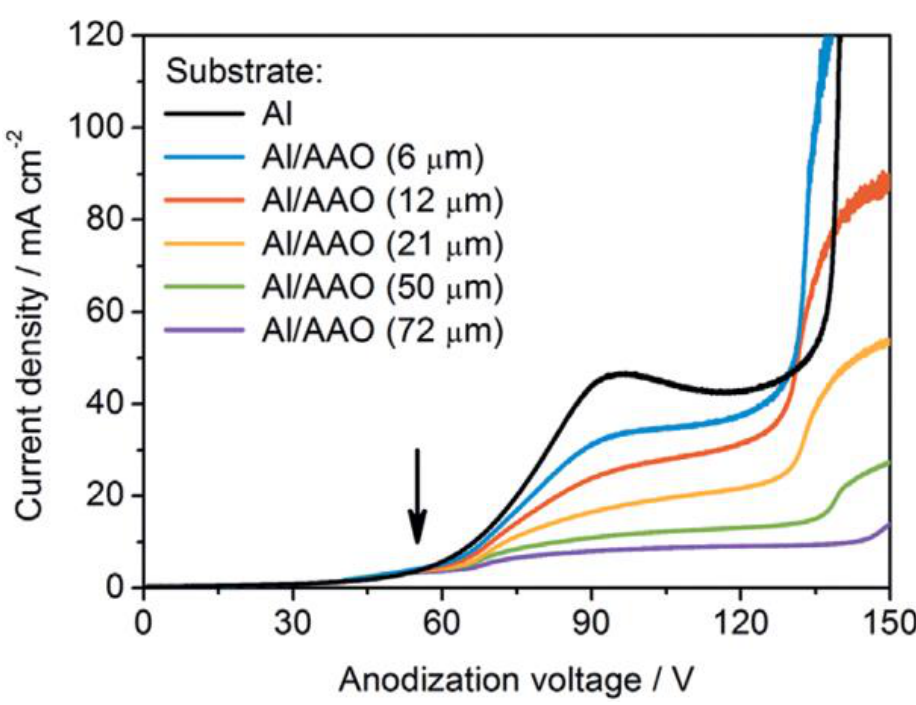
Figure 29. j – ∆ U curves obtained using two different types of Al anodes: a bare metallic foil near which the electroconvective vortical structures can freely change their sizes with progressively increased anodizing voltages (shown by the black curve), and preliminarily anodized Al foils (under MA conditions) near which the expansion of such vortices after passing the “mild” voltage range is limited by rigid pre-existing porous structures of different thicknesses (the corresponding curves are shown in different colors). The black arrow indicates the end of the MA range at ∆ U ≈ 55 V. Reproduced with permission from [143]. Copyright 2017 Elsevier.